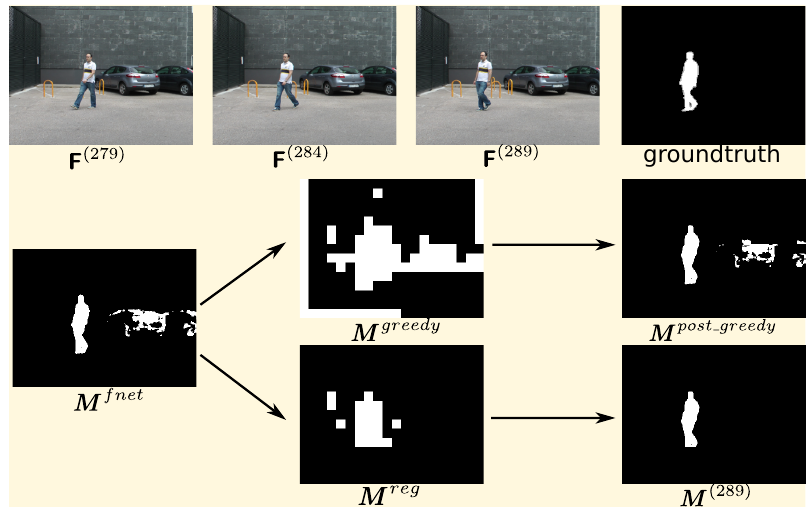
Figure 4. A sample of the performance of post-process. In this sample, parameters ( t , k 1 , k 2 , θ , β , N ) = ( 289,5,10,20,10,64 ) , respectively. M fnet is the predicted foreground mask for the frame F ( 289 ) , which is also the raw output of the fusion network with the input three frames shown in the first raw. M greedy is the region-based map proposed in a greedy strategy from the DFFnetSeg method, and M reg is the conservative one proposed in this paper. M post _ greedy and M ( 289 ) are post-processed final predictions by these two maps,